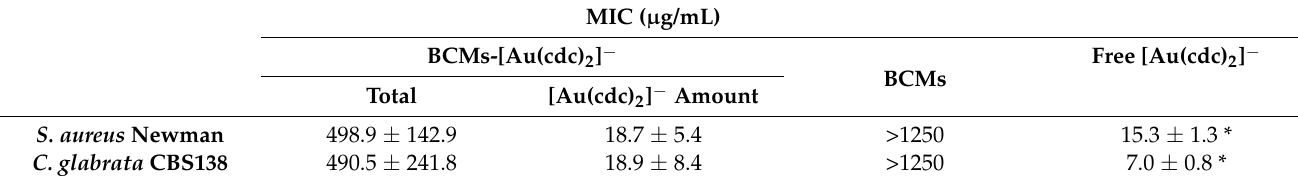
Table 7. Estimated minimum inhibitory concentrations (MICs) of BCMs-[Au(cdc) 2 ] − and BCMs with respect to S. aureus Newman and C. glabrata CBS138. Results are the means of two independent experiments performed with two replicates. MIC values were estimated considering the total amounts of BCMs-[Au(cdc) 2 ] − (Total) or the amounts of [Au(cdc) 2 ] − encapsulated in BCMs ([Au(cdc) 2 ] − Amount). MIC ( µ